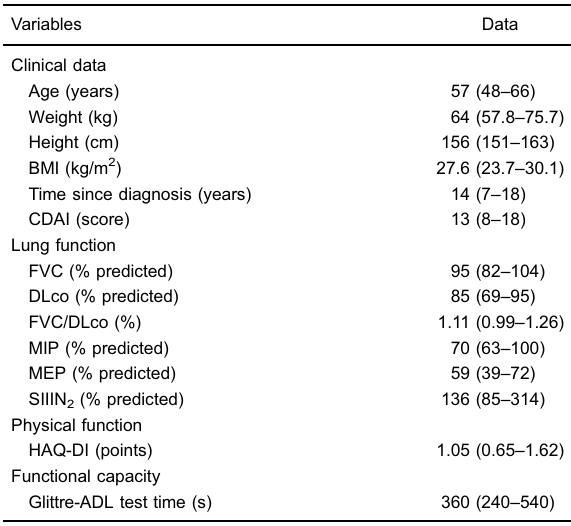
Table 1. Clinical data, lung function, physical function, and functional capacity of women with rheumatoid arthritis. Variables